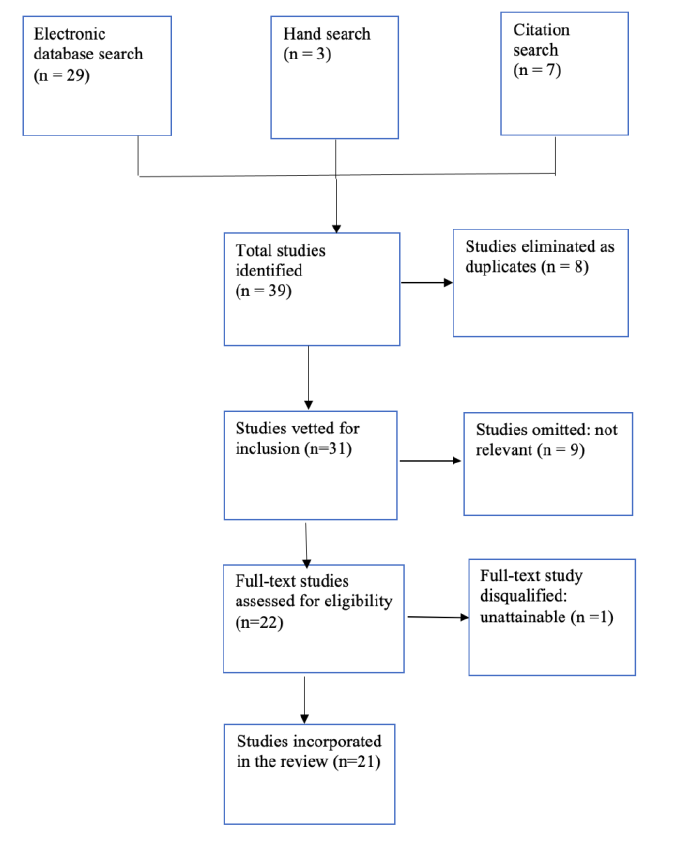
Figure 1: Study selection process